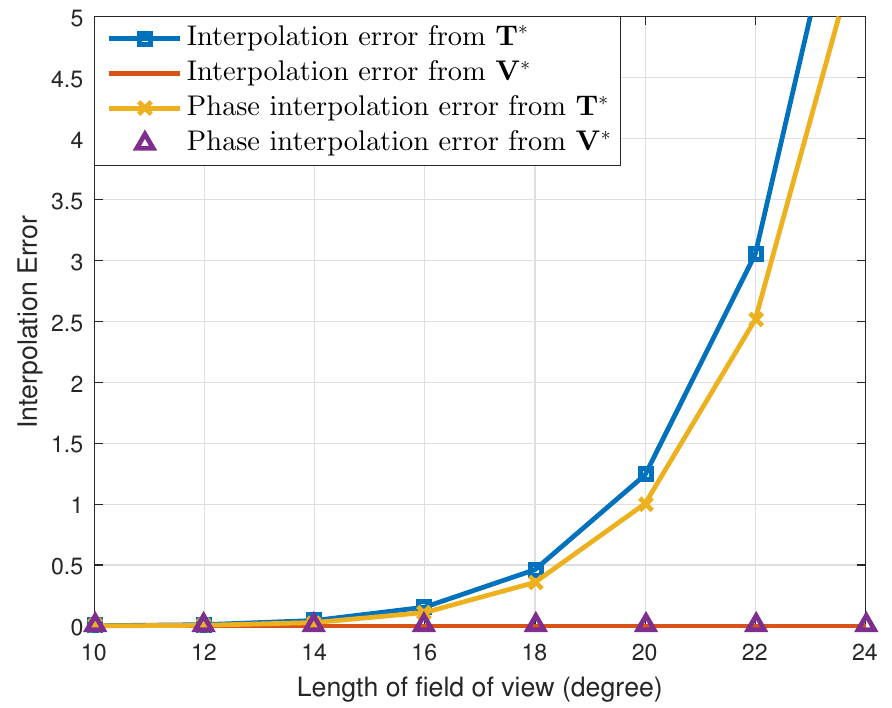
Figure 1. Two types of interpolation errors from T ∗ and V ∗